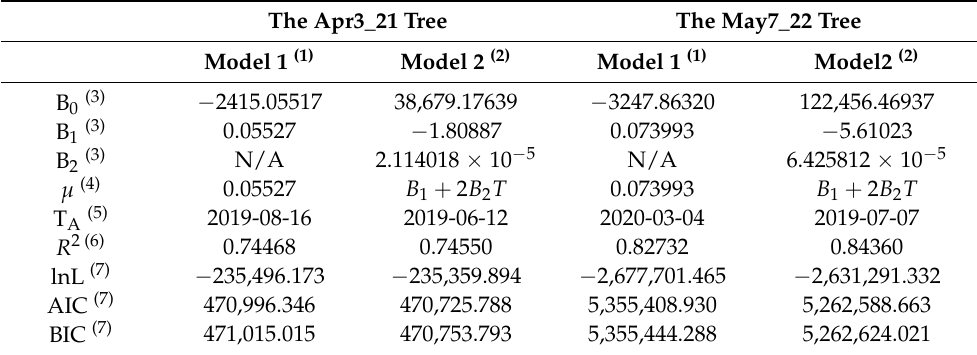
Table 2. Summary of the dating results for the Apr3_21 tree (with 83,688 leaves) and the May7_22 tree (with 970,777 leaves). Note the absurd estimation of T A under Model 1 with the May7_22 tree. The Apr3_21 Tree The May7_22